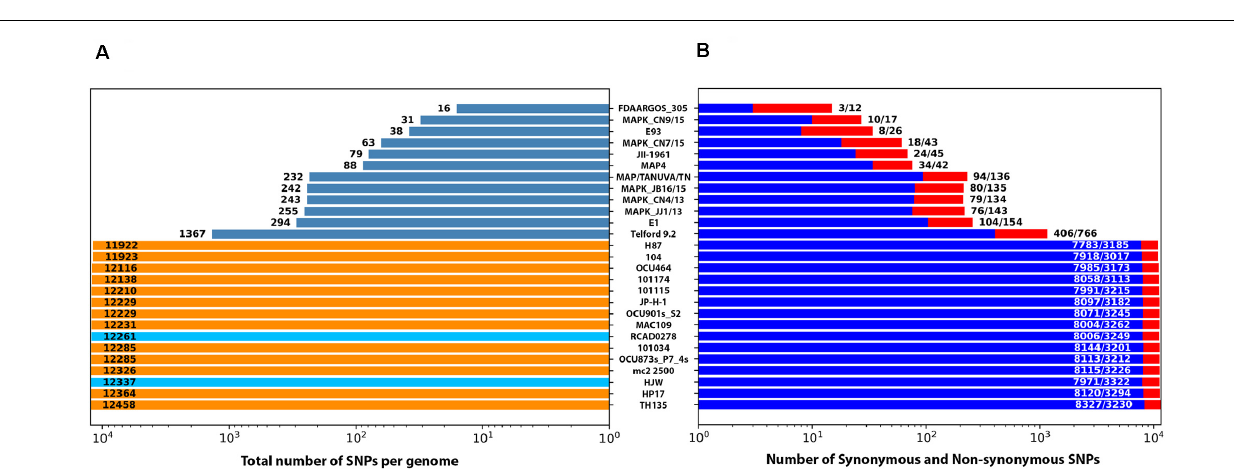
FIGURE 2 | Number of single nucleotide polymorphisms among all 28 M. avium subspecies genomes using Map K-10 as the reference genome. Shown are the total number of SNPs detected in each strain (A) with the slate bars representing Map , beige bars representing Mah and light blue bars representing Maa strains. (B) The number of synonymous (blue bars, first value) and non-synonymous (red bars, second value) SNPs. Both graphs were plotted on a log scale with the strain designation listed in the center. Numerical differences between total SNPs and the combined nonsynonymous plus synonymous SNPs represent the intergenic